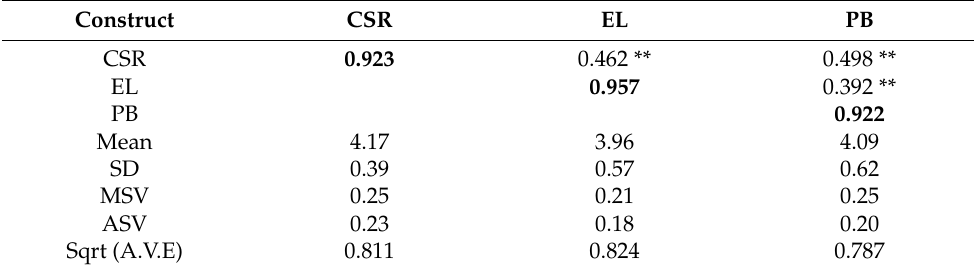
Table 4. Correlation, discriminant validity, and model fit